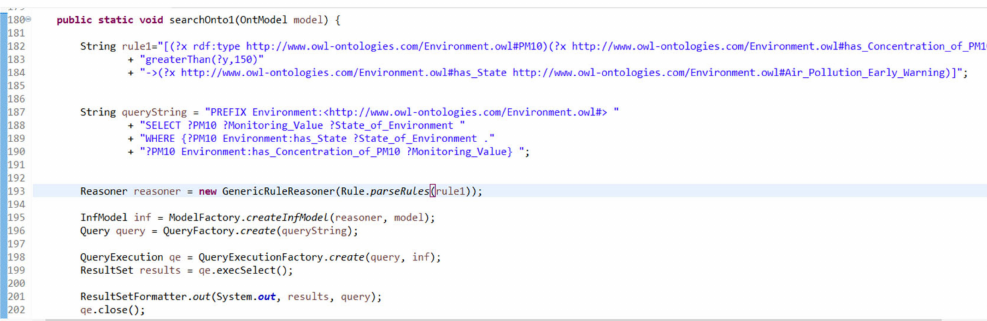
Figure 8. PM10 overrun